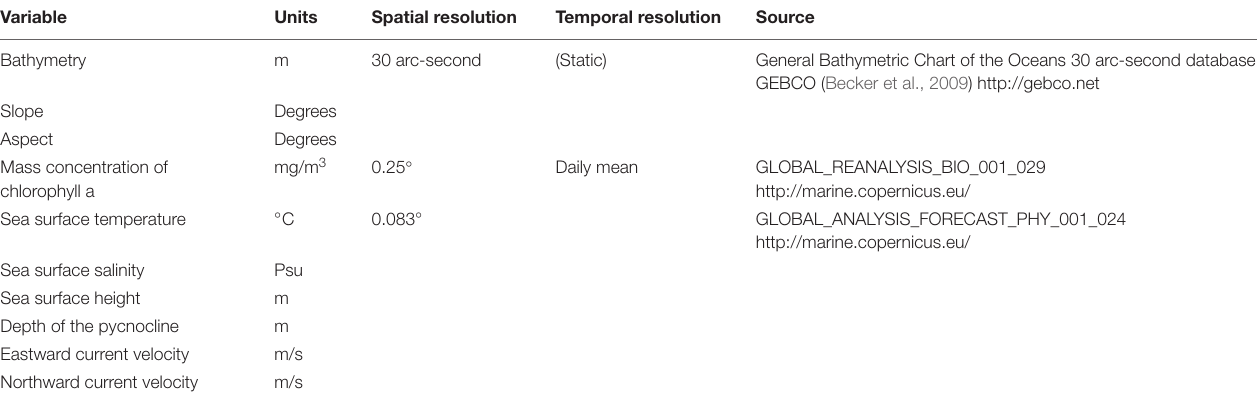
TABLE 3 | Environmental variables, derived from remote sensing, included in the models.